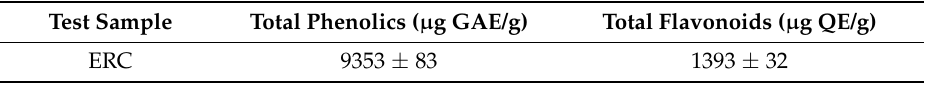
Table 1. Phytochemical contents of the R. coriaria ethanol extract (ERC). The data are means ± SEM ( n = 3).